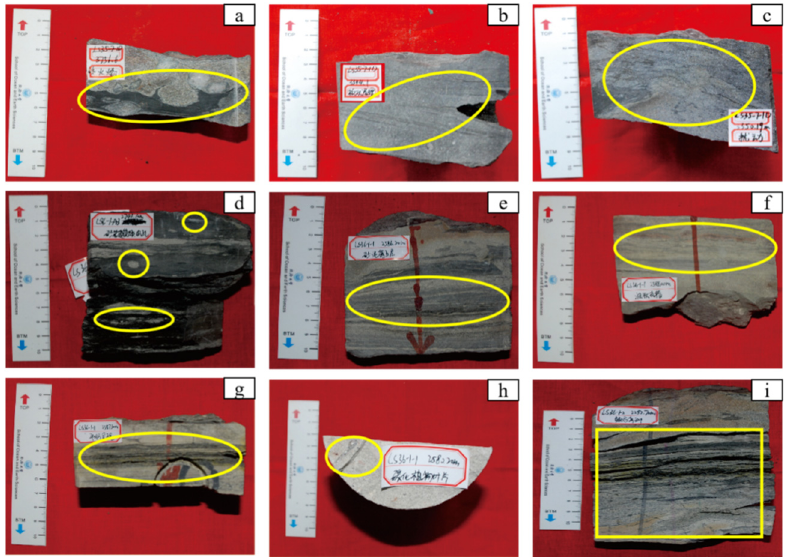
Figure 12. The sedimentary structure and paleontology of the Lishui Sag. ( a ) Flamy structure, D well, 3756.60 m, E 1 y; ( b ) tabular bedding, D well, 3344.10 m, E 1 l; ( c ) bioturbation, D well, 3350.19 m, E 1 l; ( d ) sand lens and worm burrows, C well, 2743.10 m, E 1 l; ( e ) sand-shale thin interbedding, B well, 2586.20 m, E 1 m; ( f ) wavy cross bedding, B well, 2588 m, E 1 m; ( g ) parallel bedding, B well, 2587.30 m, E 1 m; ( h ) carbonized plant fragments, B well, 2580.20 m, E 1 m; ( i ) carbonized plant fragments, A well, 2292.70 m, E 1 m.